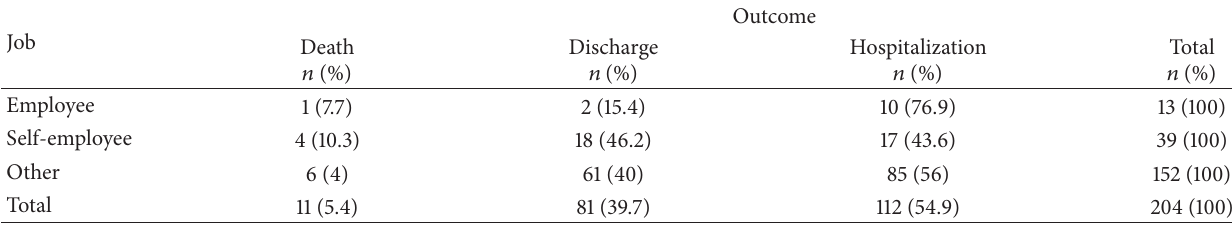
Table 4: Frequency of trauma patients by jobs and result of